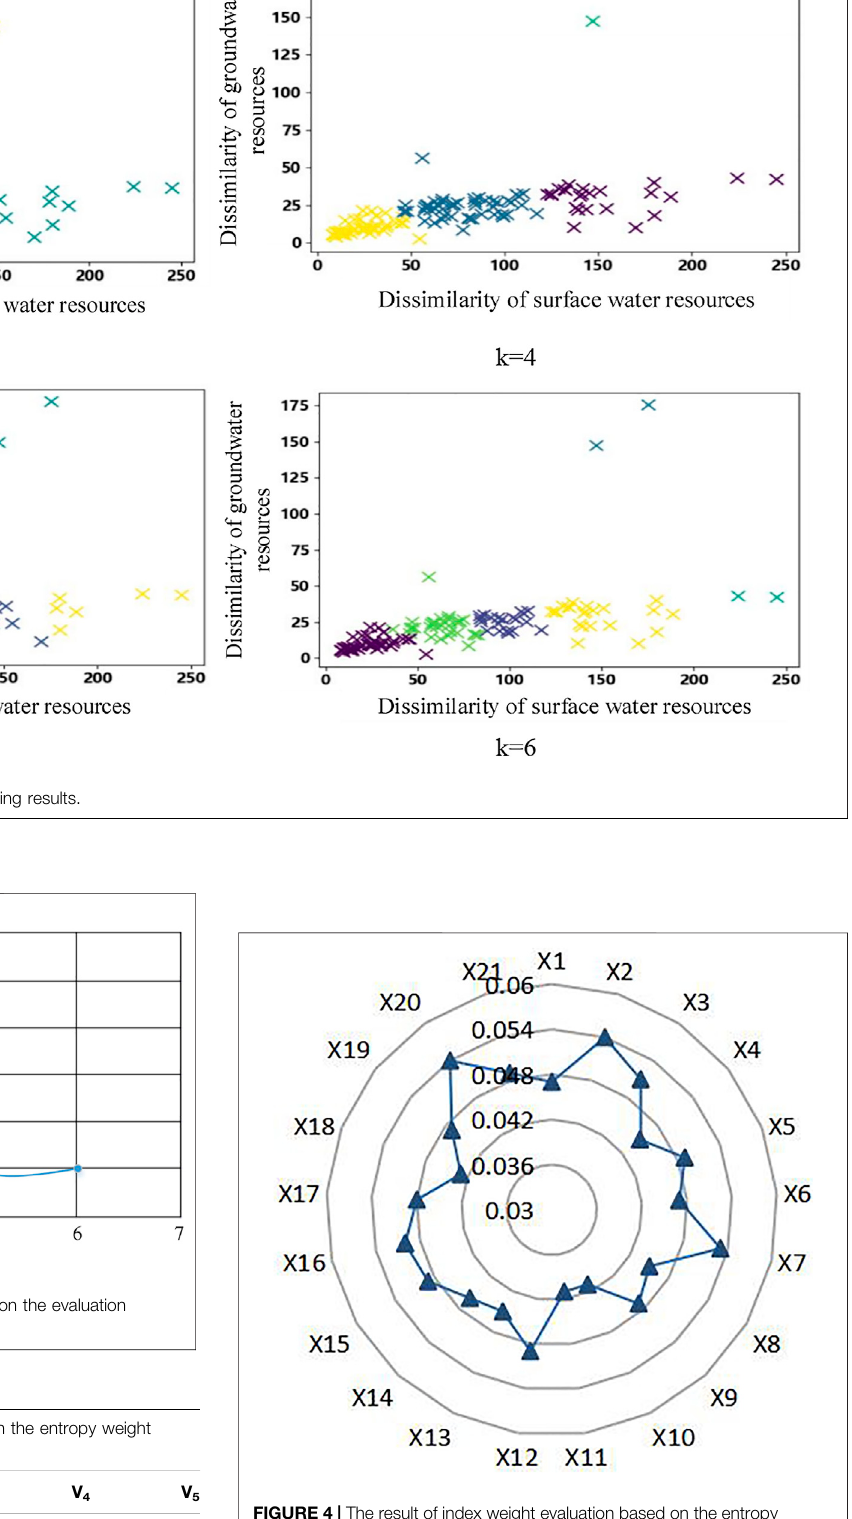
FIGURE 4 | The result of index weight evaluation based on the entropy weight